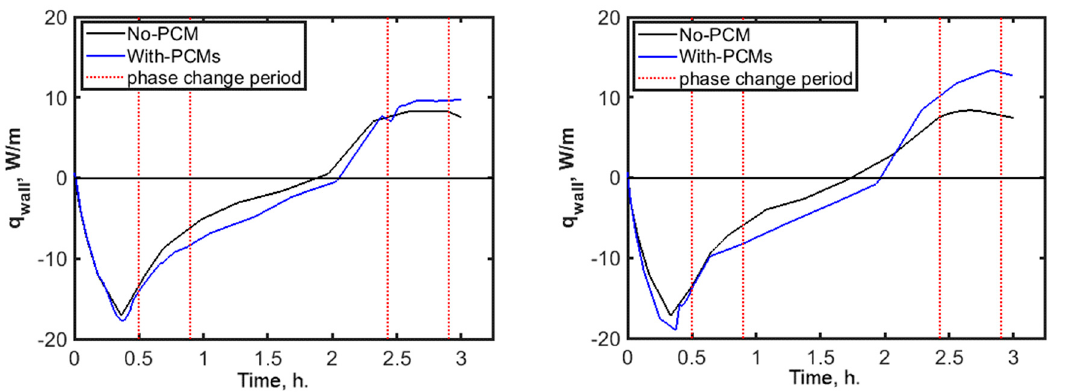
Figure 17. Effect of PCM wall heat transfer. Figure 17. E ff ect of PCM wall heat transfer.